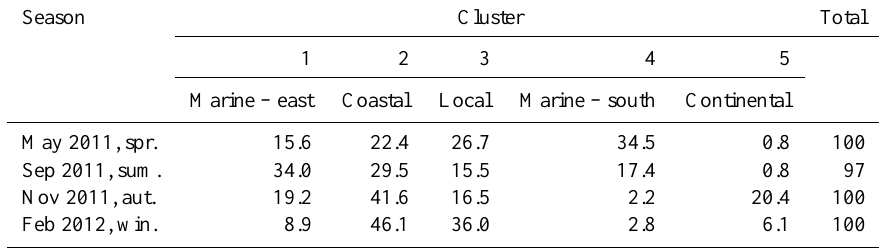
Table 1. Percentages of time split among the five clusters (300m, five-cluster solution) in each season. Season